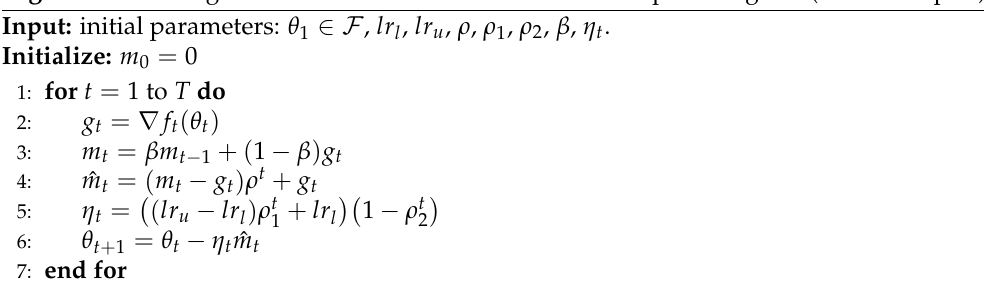
Algorithm 2 Scaling T ransition from SGDM to SGD with 2Exp learning rate (TSGD+2ExpLR)